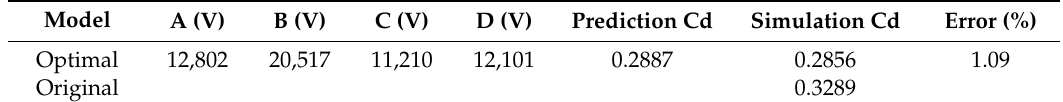
Table 2. Optimal design parameters.